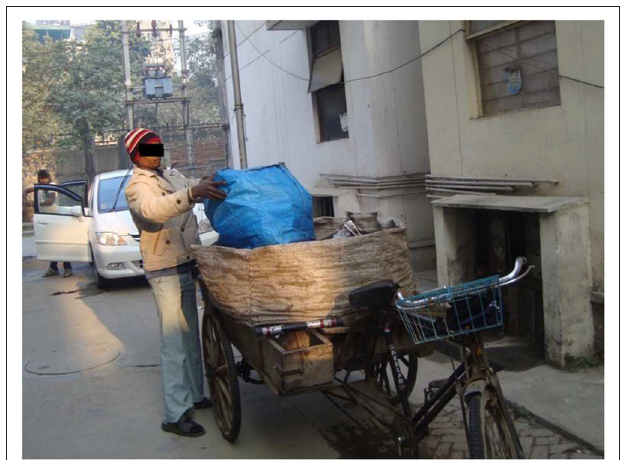
FIGURE 3 | Others waste pickers perform roadside collections.